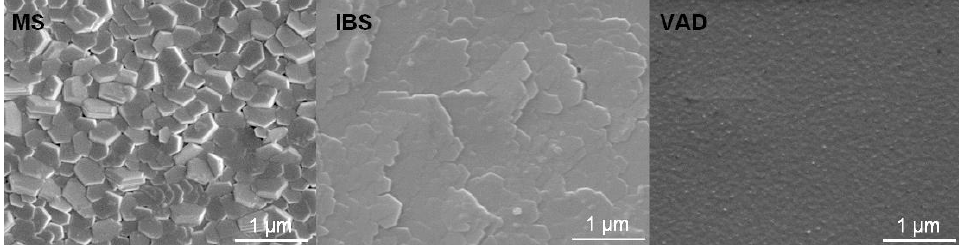
Figure 2 . Morphology of pure Mg films deposited by magnetron sputtering (MS; left panel), ion beam sputtering (IBS; middle panel) and cathodic (vacuum) arc deposition (VAD; right panel)